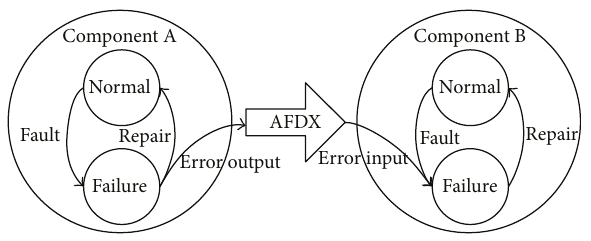
Figure 9: Error propagation behavior between components.